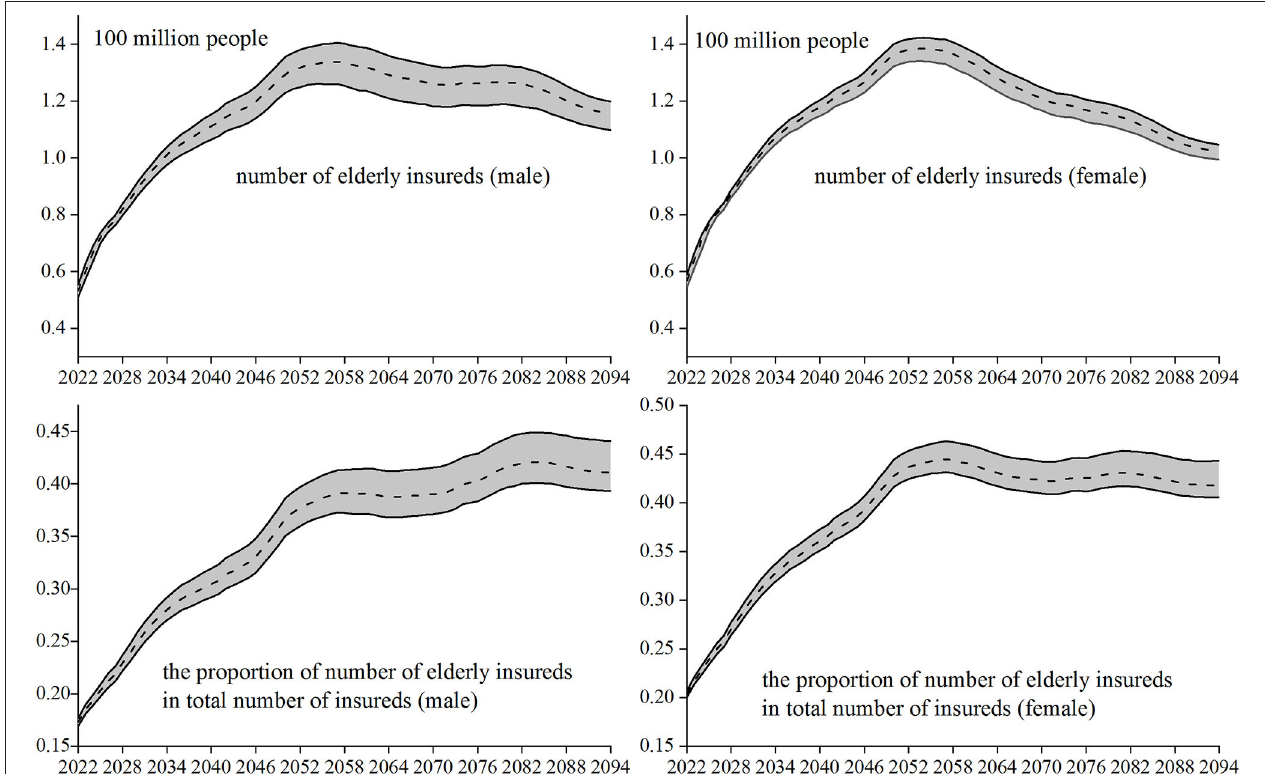
FIGURE 2 | Aging characteristics of